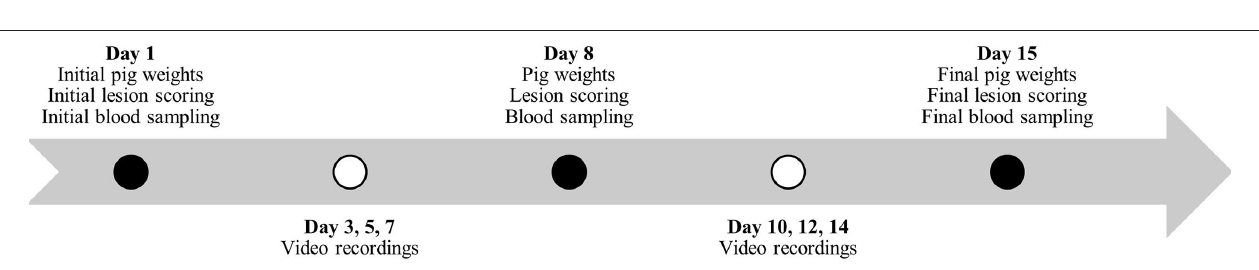
FIGURE 1 | Timeline during study #1 for pig weights, lesion scoring, blood sampling and behavior video recordings.